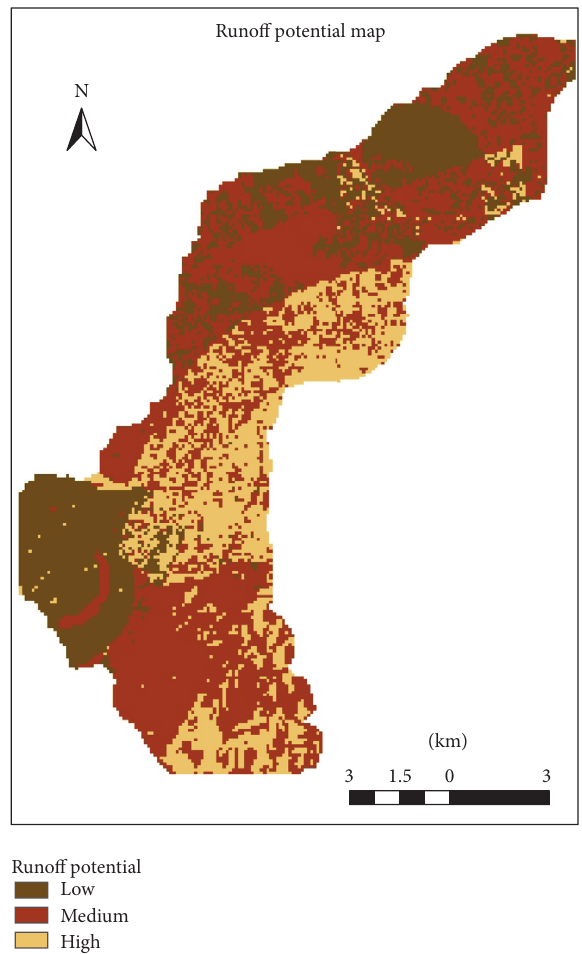
Figure 7: Runoff potential